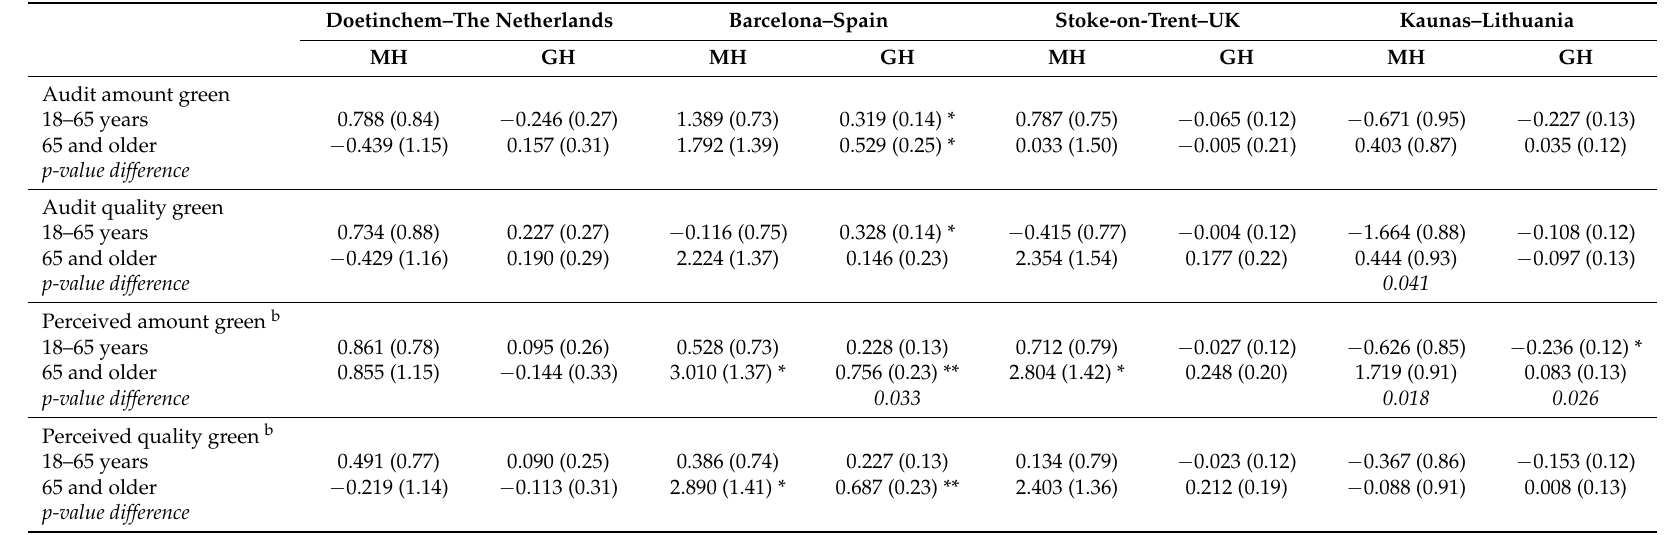
Table 4. Multilevel regression analysis for the relationship between neighbourhood green space (standardised estimates) and mental health (MH) and general health (GH) (standard errors in parentheses), by age (for significant differences between subgroups the p -value is provided) a